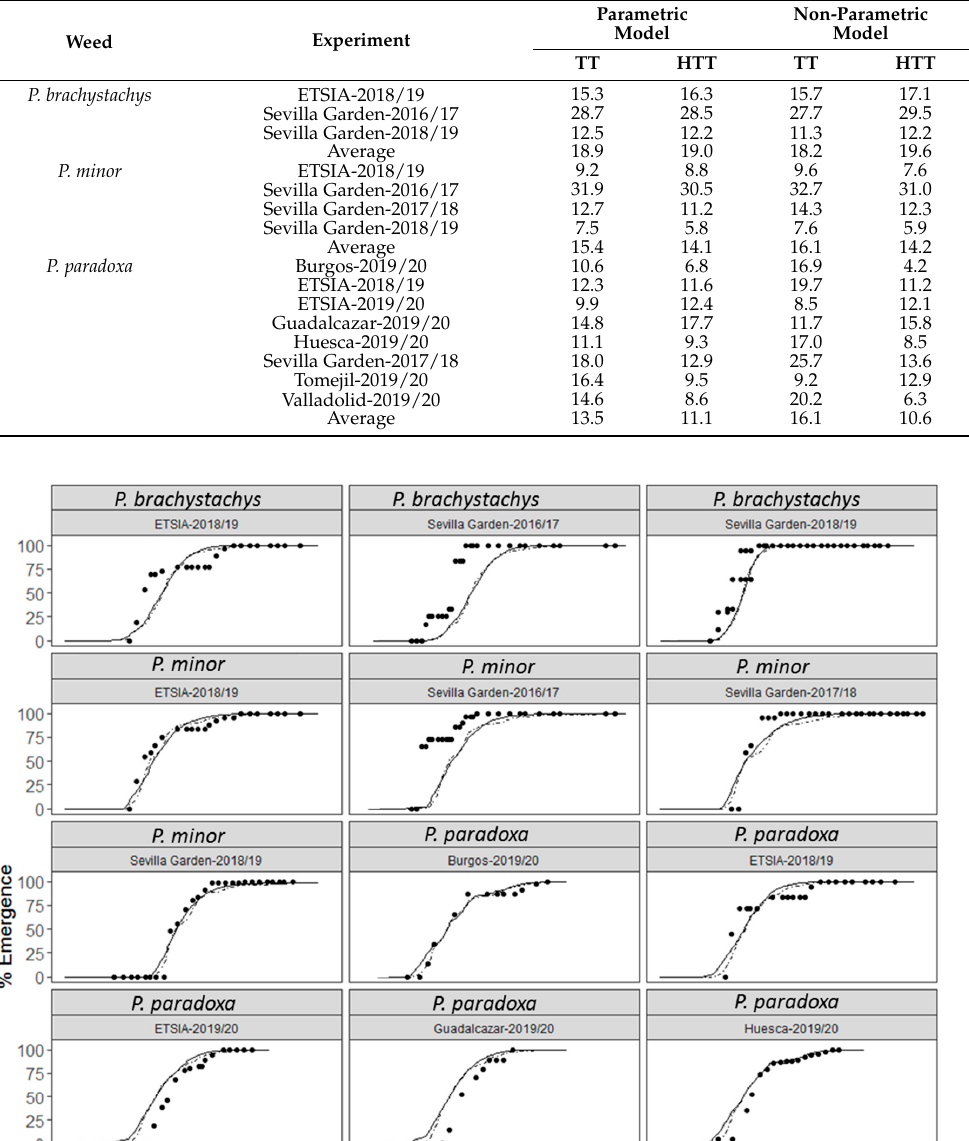
Table 9. Root mean square error (RMSE) values obtained from thermal (TT) and hydrothermal (HTT) times of parametric and non-parametric models at each validation location. Numbers in bold show the lowest RMSE value in each location and season.